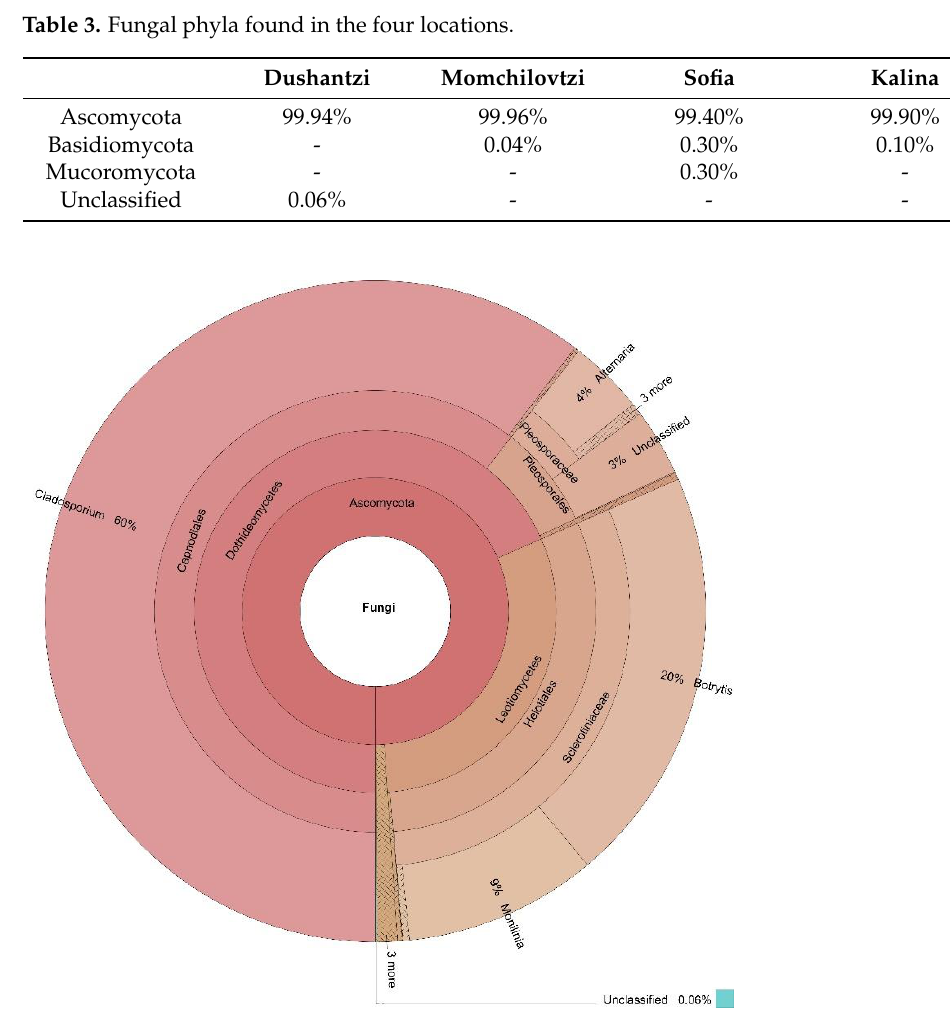
Figure 3 . Krona display of the fungal composition of the samples from Momchilovtzi.